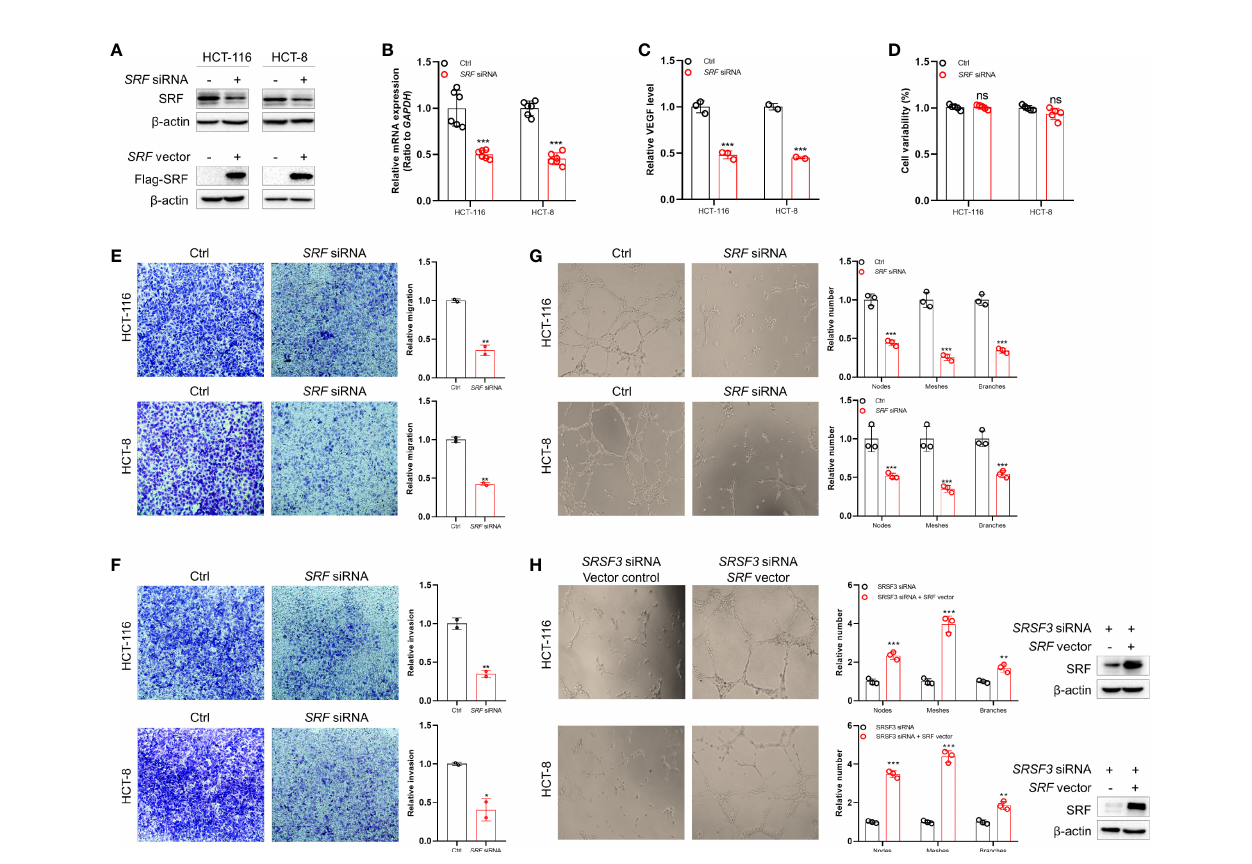
FIGURE 5 | The SRF-promoted angiogenesis in CRC. (A) Western blotting assays for verifying SRF siRNA and expression vector in HCT-116 and HCT-8 cells. (B) qPCR assays for verifying SRF siRNA in HCT-116 and HCT-8 cells ( n =6). (C) ELISAs to investigate the effects of SRF silencing on VEGF secretion in HCT-116 and HCT-8 cells ( n =3). (D) MTT assays for investigating the effects of CM from SRF-knockdown HCT-116 and HCT-8 cells on the proliferation of HUVECs ( n =6). (E) Transwell assays to investigate the effects of CM on the migration of HUVECs ( n =2). (F) Transwell assays to investigate the effects of CM on the invasion of HUVECs ( n =2). (G) The effects of CM on the tube formation of HUVECs ( n =3). (H) The effects of CM from HCT-116 and HCT-8 cells transfected with SRSF3 siRNA and SRF expression plasmid on the tube formation of HUVECs ( n =3). Data represent mean±SD. Signi fi cance was assessed by two-sided t test. *** P <0.001; ** P <0.01; ns, no signi fi